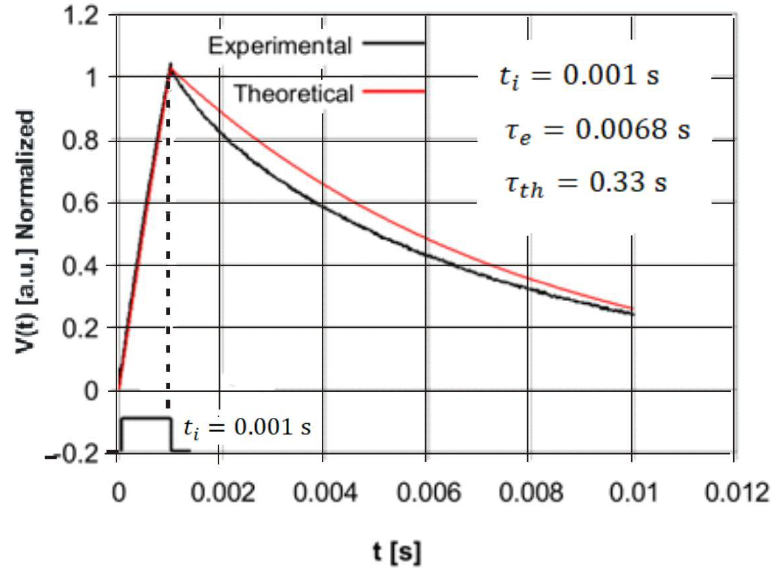
Figure 8. Comparison of the normalized experimental and theoretical voltage responses of the PE10-S-Q detector to the rectangular radiation pulse of duration t i = 0.001 s.